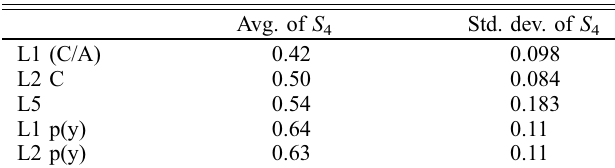
Table 2. Averages and Standard deviation of GPS satellite 25 for 11th April 2013 between [18:00, 19:30] UTC.